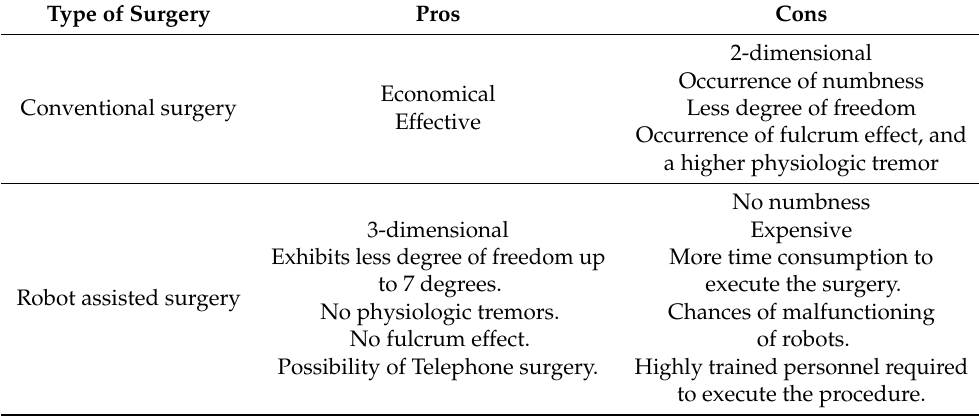
Table 4. The pros and cons of robot-assisted surgery compared to conventional surgery. Type of Surgery Pros Cons